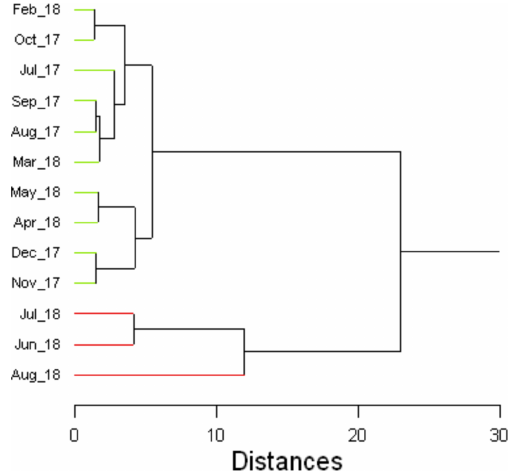
Figure 3. Cluster analysis dendrogram of the fatty acid composition of C. nodosa leaves. Summary statistics are given in Table S3.